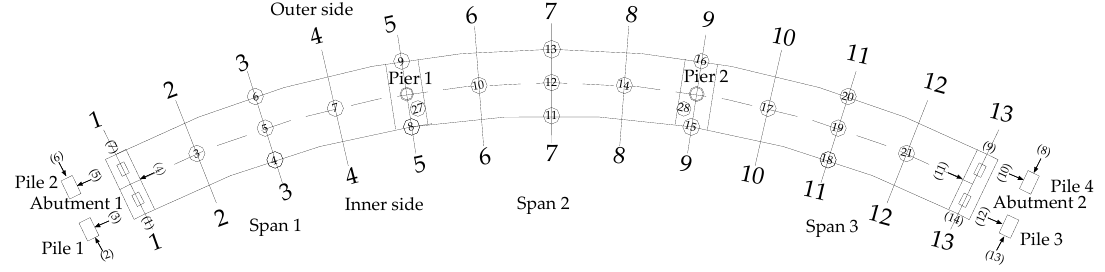
Figure 3. Arrangement plan of testing cross sections and dial indicators.